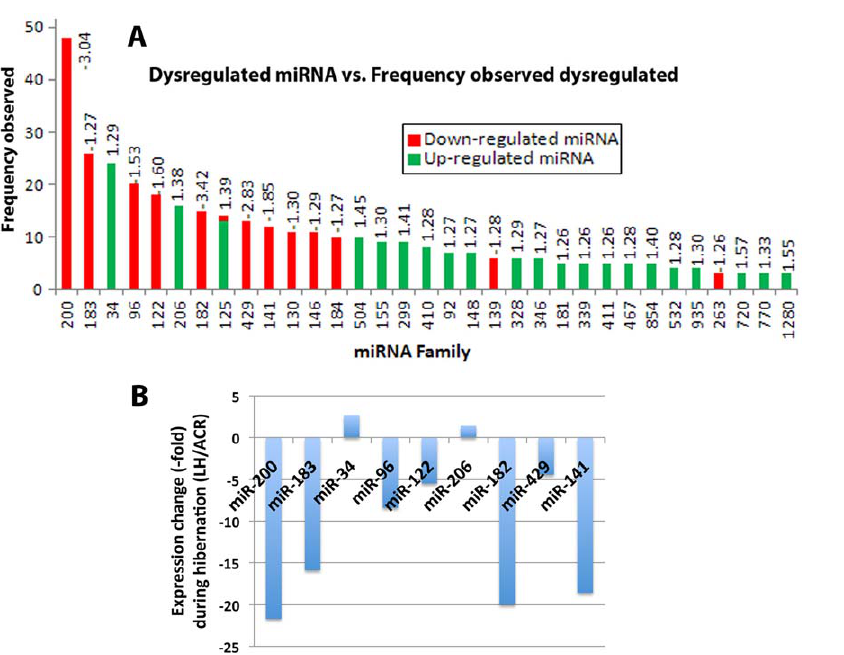
Figure 2. Differentially regulated miRNA families in the brains of 13-lined ground squirrels during hibernation. (A) 405 miRNAs which had an absolute mean difference between LH and ACR $ 1.25 (using 6 different animal samples for each condition) were grouped into 33 families, and plotted against the frequencies observed. Down-regulated miRNAs were shown in red, and up-regulated miRNAs were shown in green. The number on top of each column is the fold change (ACR vs LH). (negative number=decrease, positive number=increase). (B) A subset of differentially regulated miRNAs detected by miRNA microarray was validated by qPCR using the same RNA samples that had been used for the miRNA microarray. The levels of the miRNAs were normalized by the level of miR-103, which was among the most stably expressed miRNAs with expression levels that did not change during the hibernation bout, and expressed as ratios of LH/ACR.